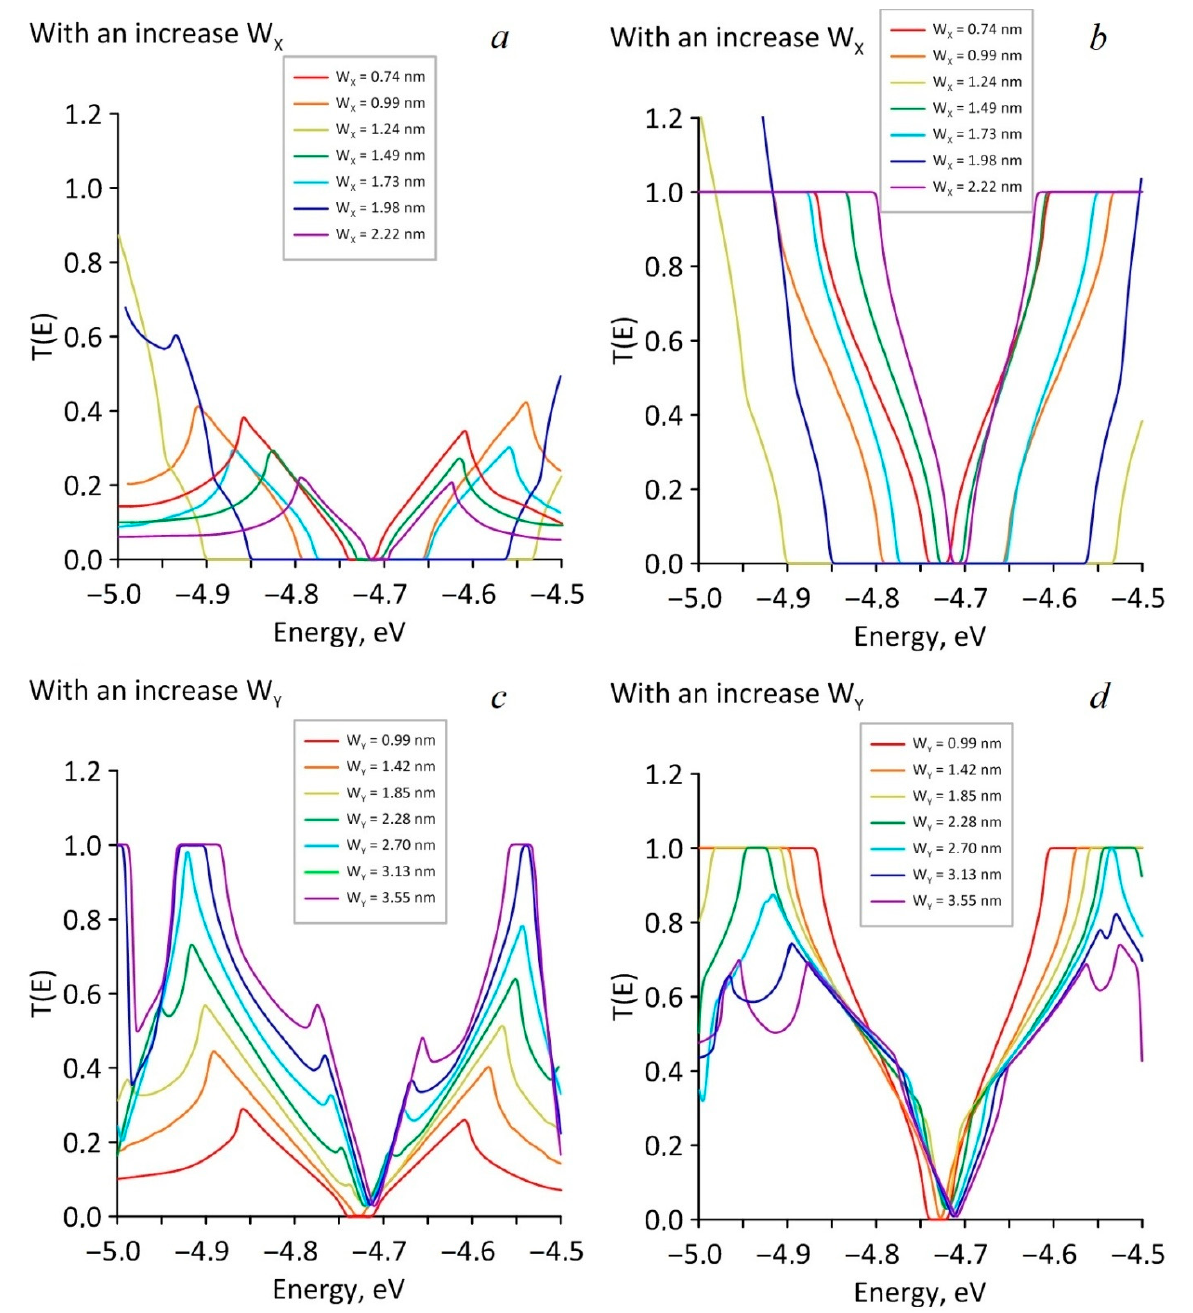
Figure 5. Graphs of HG transmission function T(E) (in e 2 /2h) in the case of Wx increasing: ( a ) for the current transfer along the zigzag direction; ( b ) along the armchair directions; and in the case of Wy increasing: ( c ) along the zigzag direction; ( d ) along the armchair